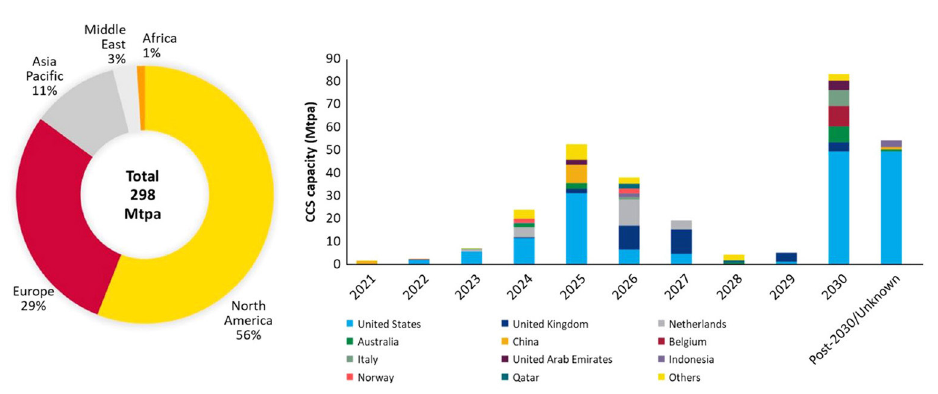
Fig. 10. – Geographical and time distribution of CCS capacity